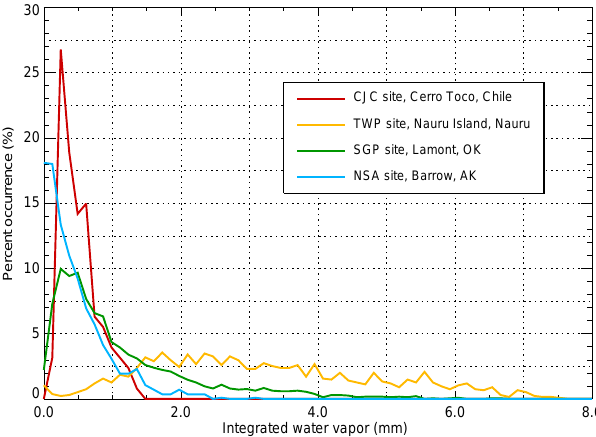
Figure 7. Median (uncorrected) RH profiles for four arm sites. RH is grouped in 25hPa bins (starting at 1000hPa), and the median is computed from that bin. There are 142 soundings for the CJC site, 2500 soundings across the annual cycle for the SGP and TWP (Nauru) sites, and 1712 soundings for the NSA site.